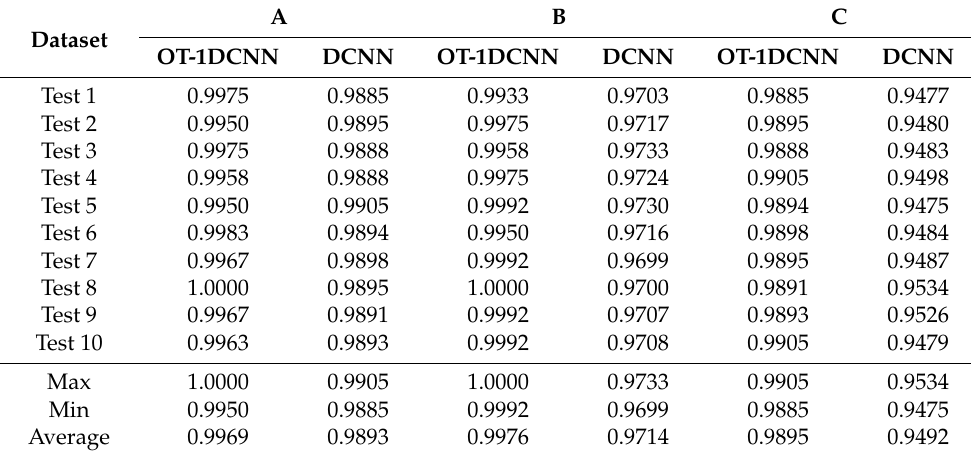
Table 4. Diagnosis results of each dataset.